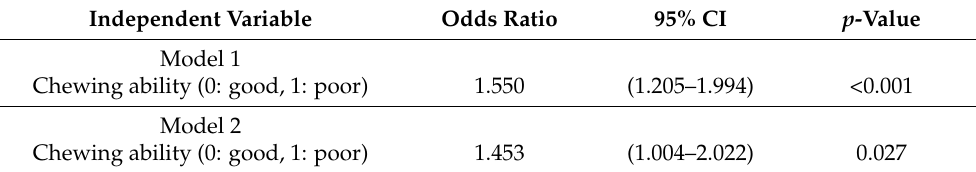
Table 3. Relationship between chewing ability and nutritional